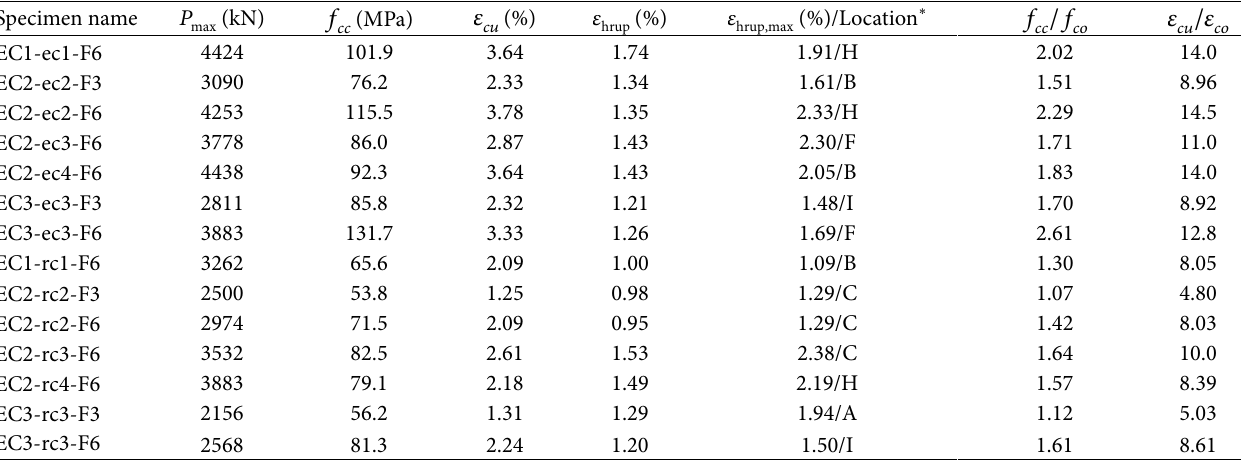
Table 4: Key test results.